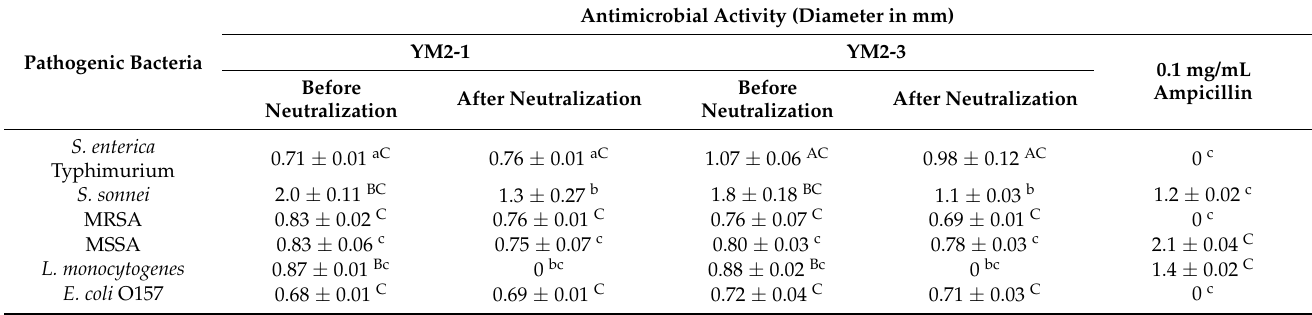
Table 2. Antimicrobial activity of concentrated CFCSs of YM2-1 and YM2-3 against six pathogenic bacteria.